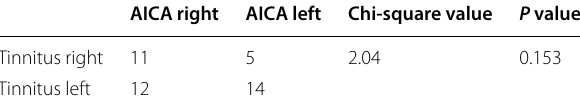
Table 3 Correlation between AICA and